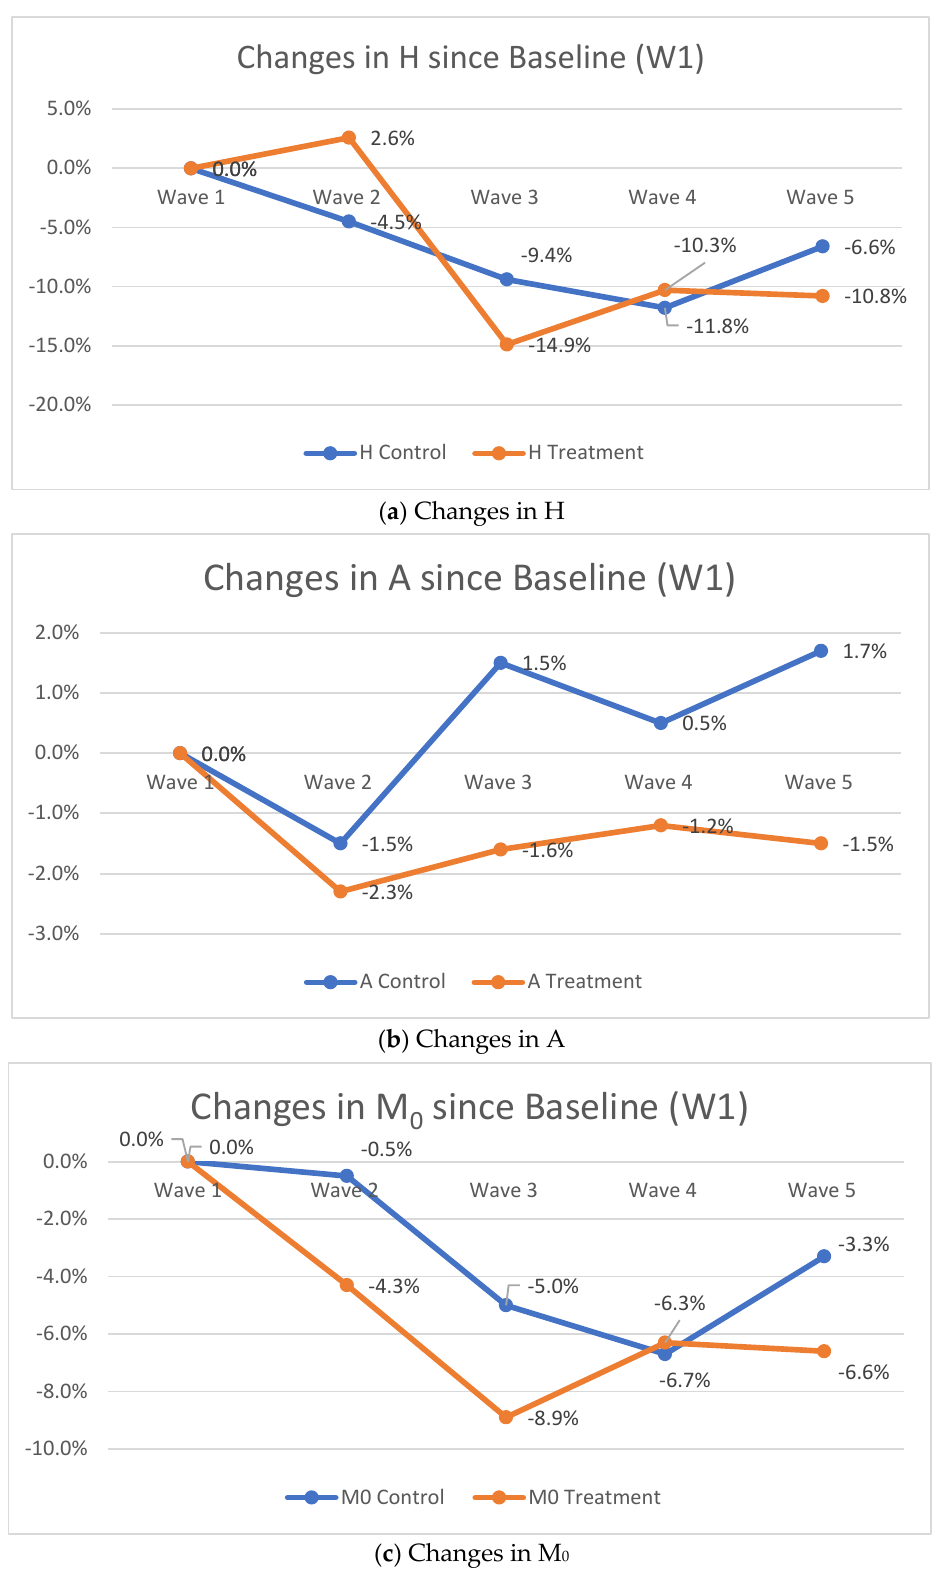
Figure 3. MPI Results: the changes between different time points and baseline in percentage points.